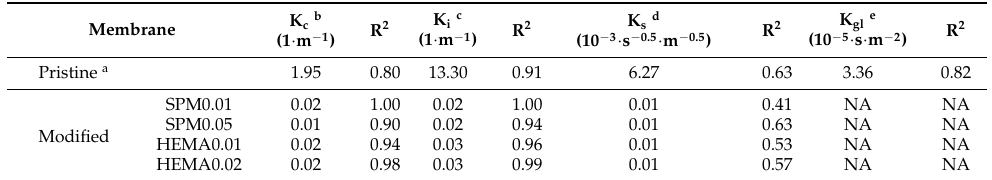
Table 3. K values and the goodness of fit (R 2 ) for silica-fouled pristine and modified NF90 determined using the modified Hermia model.